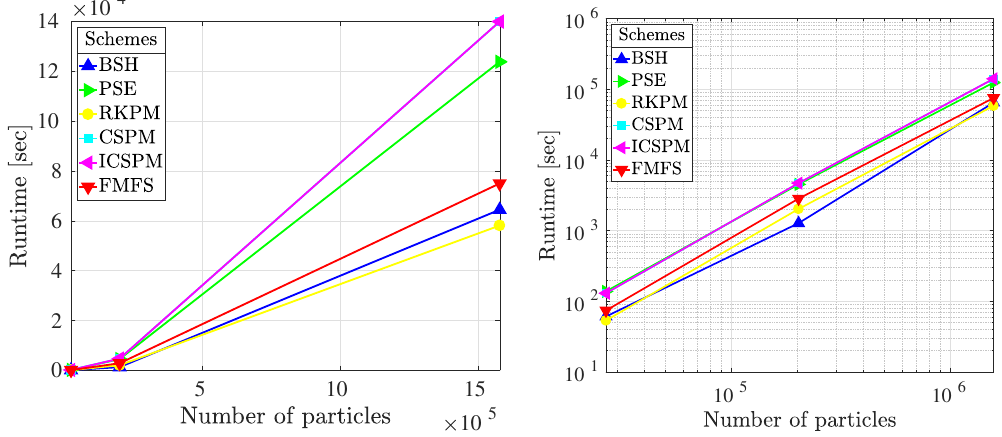
Figure 9. Comparison of the measured CPU times in both linear ( left ) and log–log ( right )